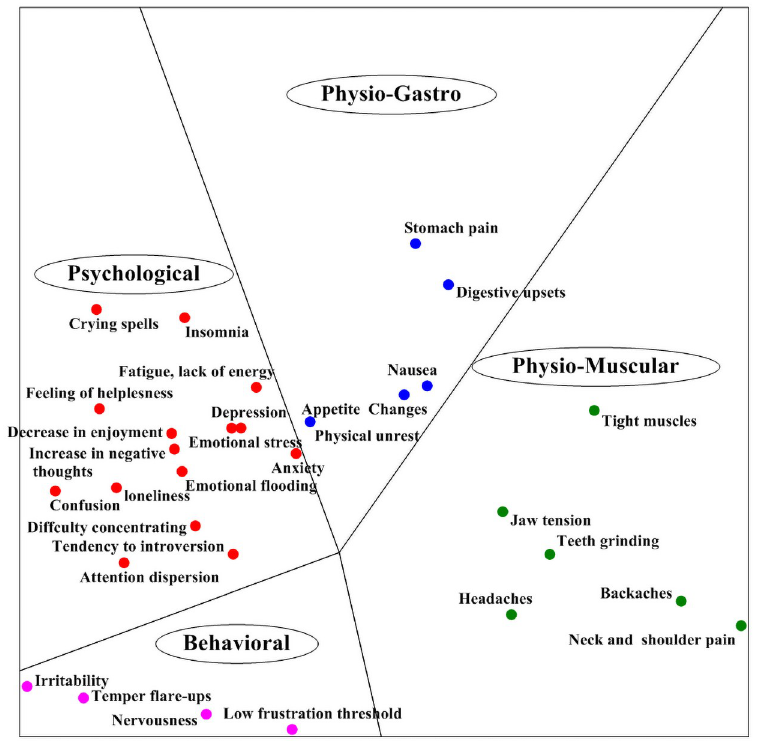
Fig 1. Map of smallest space analysis (SSA) of stress